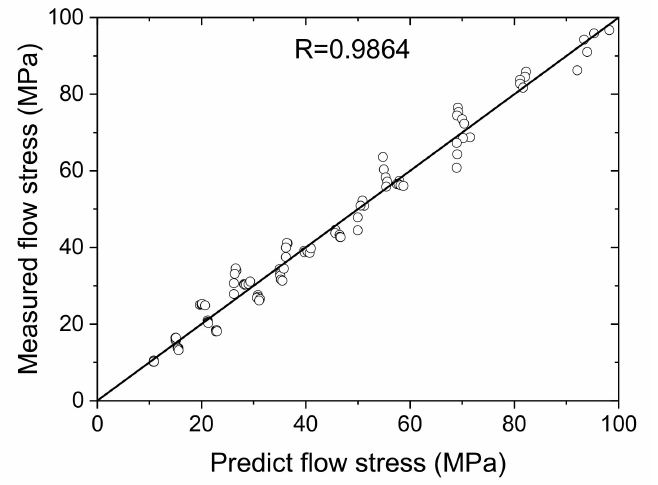
Figure 9. Correlation between the measured flow stresses and predicted flow stresses by the Sellars– Tegart